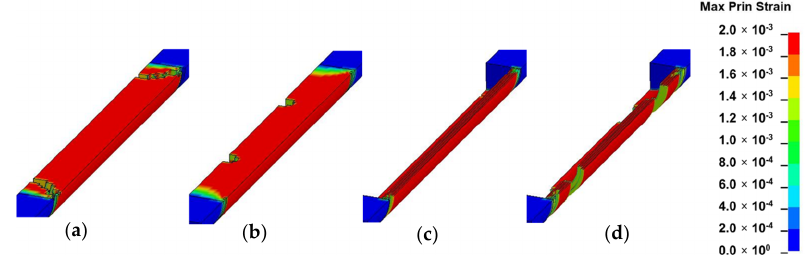
Figure 11. Fringe plots of maximum principal strain of: ( a ) solid-homogeneous; ( b ) solid-inhomogeneous; ( c ) hollow-homogeneous and ( d ) hollow-inhomogeneous models in compression mode.